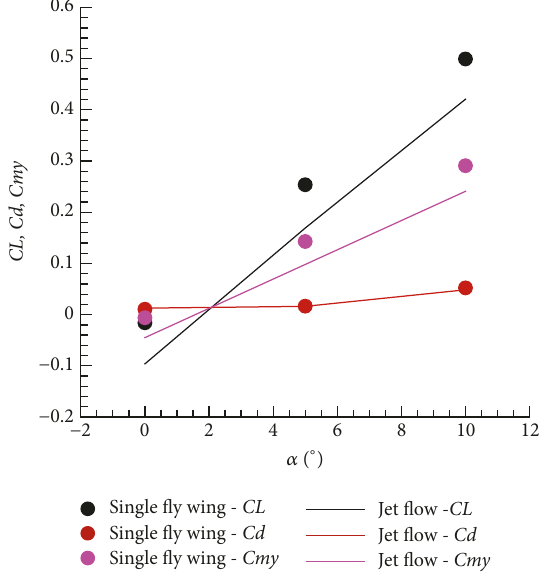
Figure 13: Steady aerodynamics-lift coefficients Cl , drag coefficients Cd , and pitching moment coefficients Cmy .